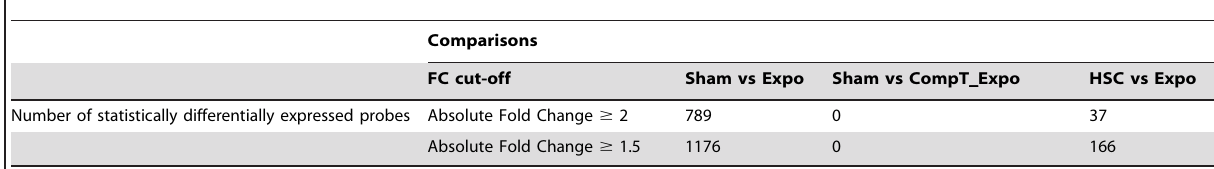
Table 1. Number of significantly differentially expressed probes between experimental conditions.